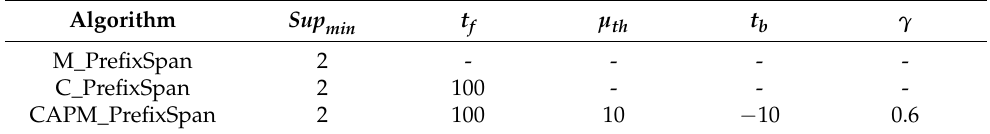
Table 6. Detailed parameters of each